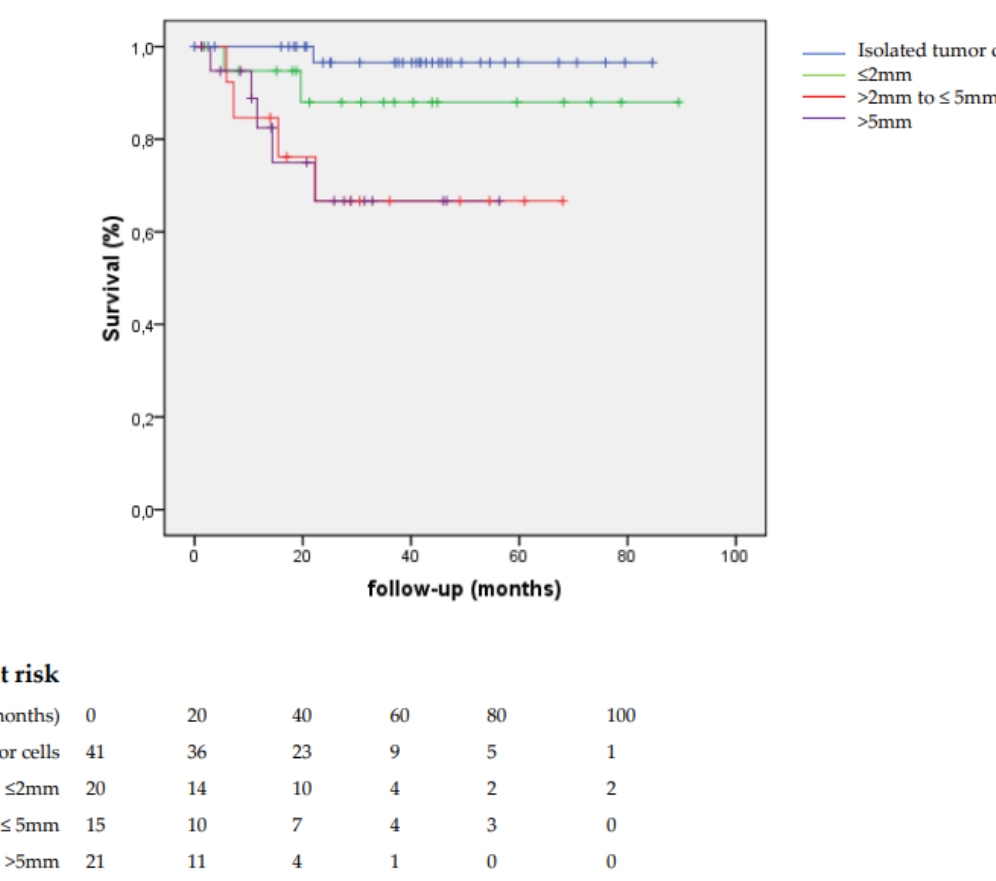
Figure 1. Disease specific survival of patients with a metastatic sentinel node, by size of metastase. Only patients with unifocal disease of the vulva were included this analysis. The median follow-up time was 105 months (range 0–179). The local recurrence rate for sentinel lymph node-negative patients was 24.6% at 5 years and 36.4% at 10 years after primary treat- ment, and for sentinel lymph node-positive patients 33.2% and 46.4%, respectively ( p = 0.03). In 15.4% of the sentinel lymph node-negative patients, inguinofemoral lymphadenectomy was performed during follow-up, as part of treatment for a macroinvasive local recurrence. The isolated groin recurrence rate was 2.5% for sentinel lymph node-negative patients and 8.0% for sentinel lymph node-positive patients at 5 years and 10 years. Isolated distant recurrences were not observed in sentinel lymph node-negative patients and in 6.8% for sentinel lymph node-positive patients at 5 and 10 years. All groin and distant recurrences were diagnosed within 25 months after primary treatment. Sentinel lymph node-negative patients had a significantly better 5- and 10-year disease-specific survival of 93.5% and 90.8%, respectively, compared to sentinel lymph node-positive patients (75.5% and 64.5%, respectively ( p < 0.0001)). For all patients, 10-year disease-specific survival decreased from 90% for patients without to 69% for patients with a local recurrence ( p < 0.0001). Local recurrences in vulvar cancer not only compromise survival; the need for an inguinofemoral lymphadenectomy means that these patients do not have the advantage of primary treatment with a sentinel lymph node procedure anymore. The advantages